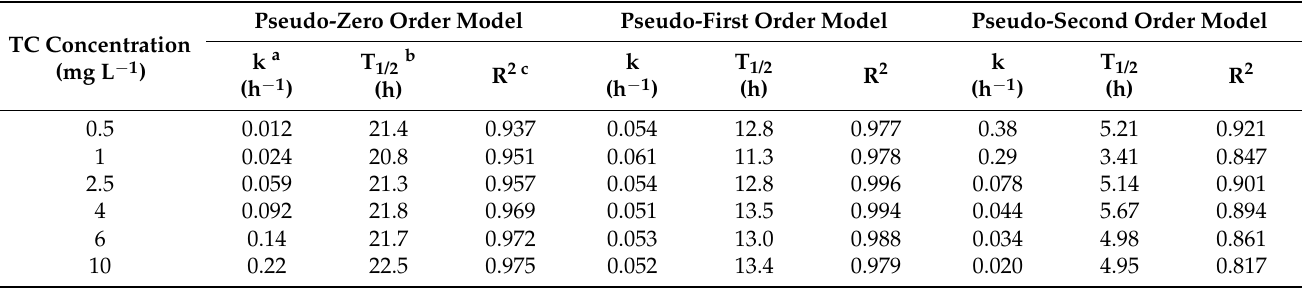
Figure 5. Time course profiles of TC removal rates by C. pyrenoidosa ( A ) and mass balance of TC in terms of biodegradation, bioaccumulation, bioadsorption, and abiotic processes after 48 h of exposure ( B ). Table 1. Kinetic parameters of TC removal by C. pyrenoidosa after 48 h of exposure.